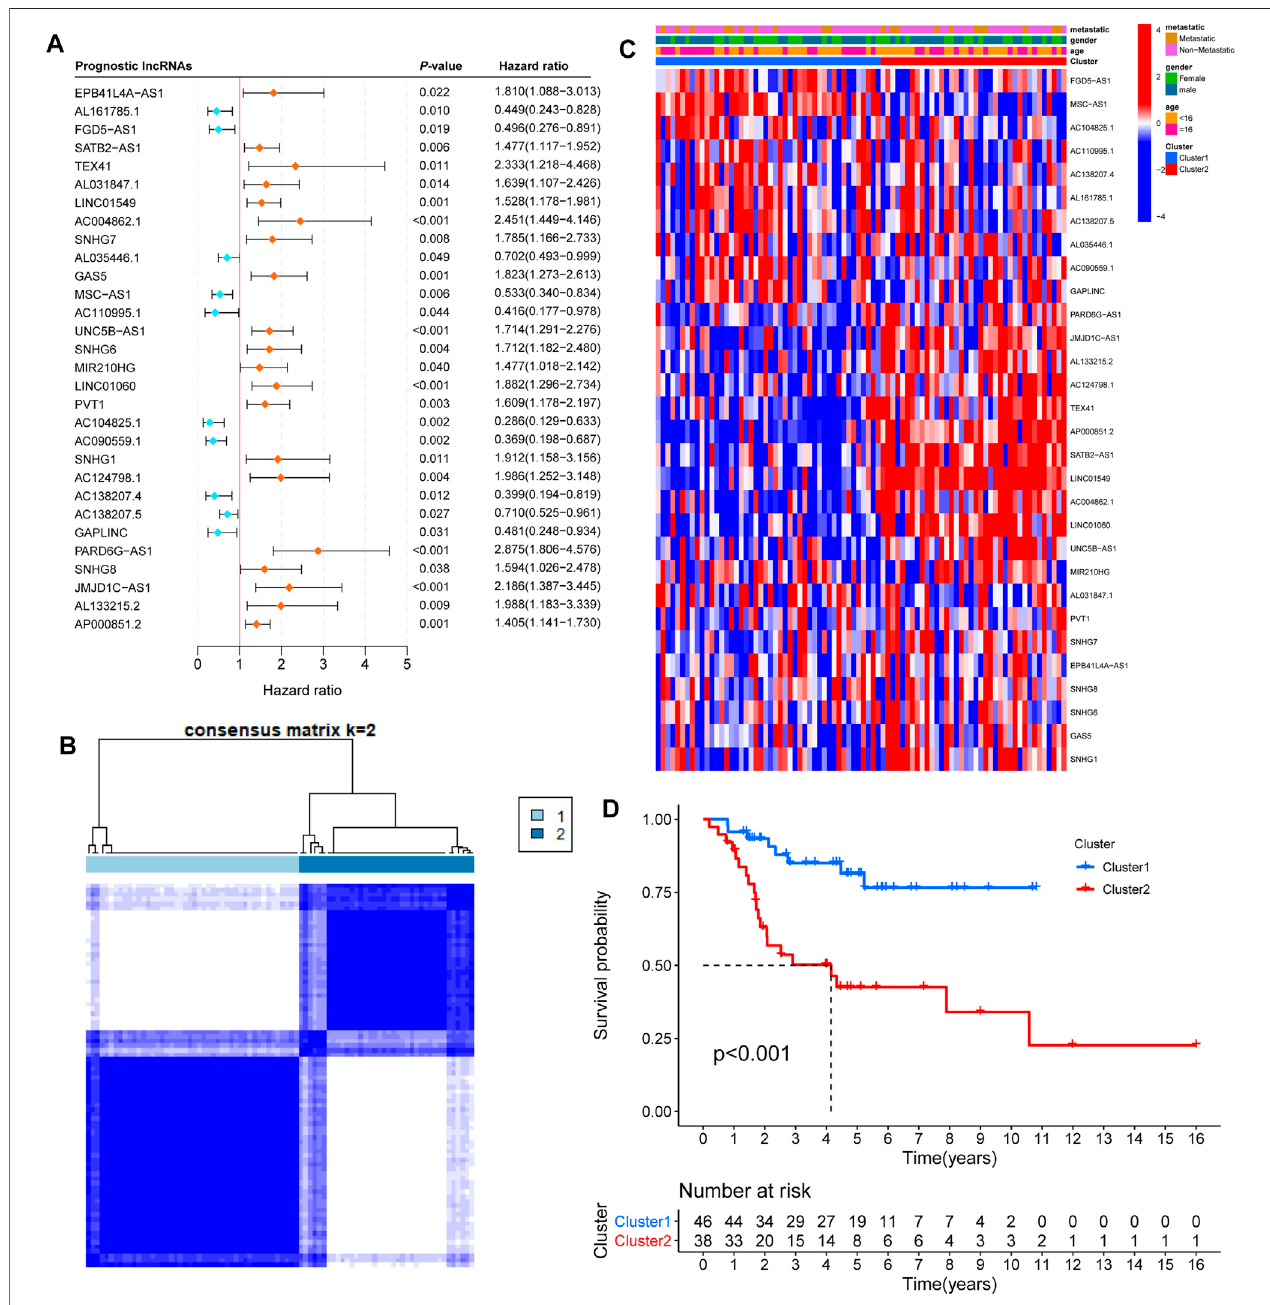
FIGURE 2 | Consensus clustering by prognosis-related lncRNAs. (A) Univariate Cox regression analysis showed that 30 iron metabolism-related lncRNAs signi fi cantlycorrelated withthe overall survivalof OSpatients.Orange and bluish dots representthe point estimation ofthehazard ratio. (B) Theconsensus score matrix of 84 samples when k = 2. (C) Heatmap with clinical information for 30 iron metabolism-related lncRNAs. (D) Kaplan – Meier curves of patients in two clusters.